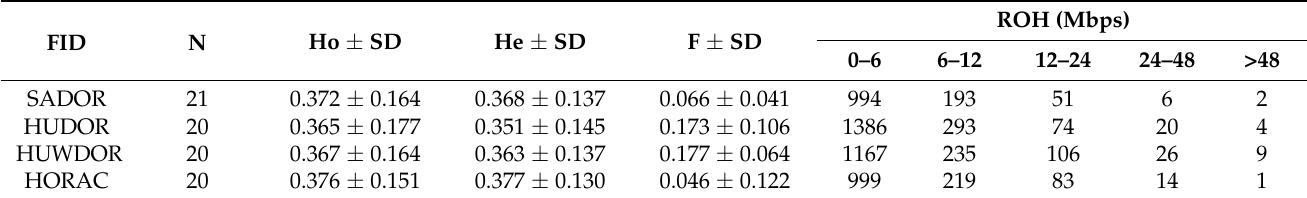
Table 1. Basic population genomic statistics and runs of homozygosity.